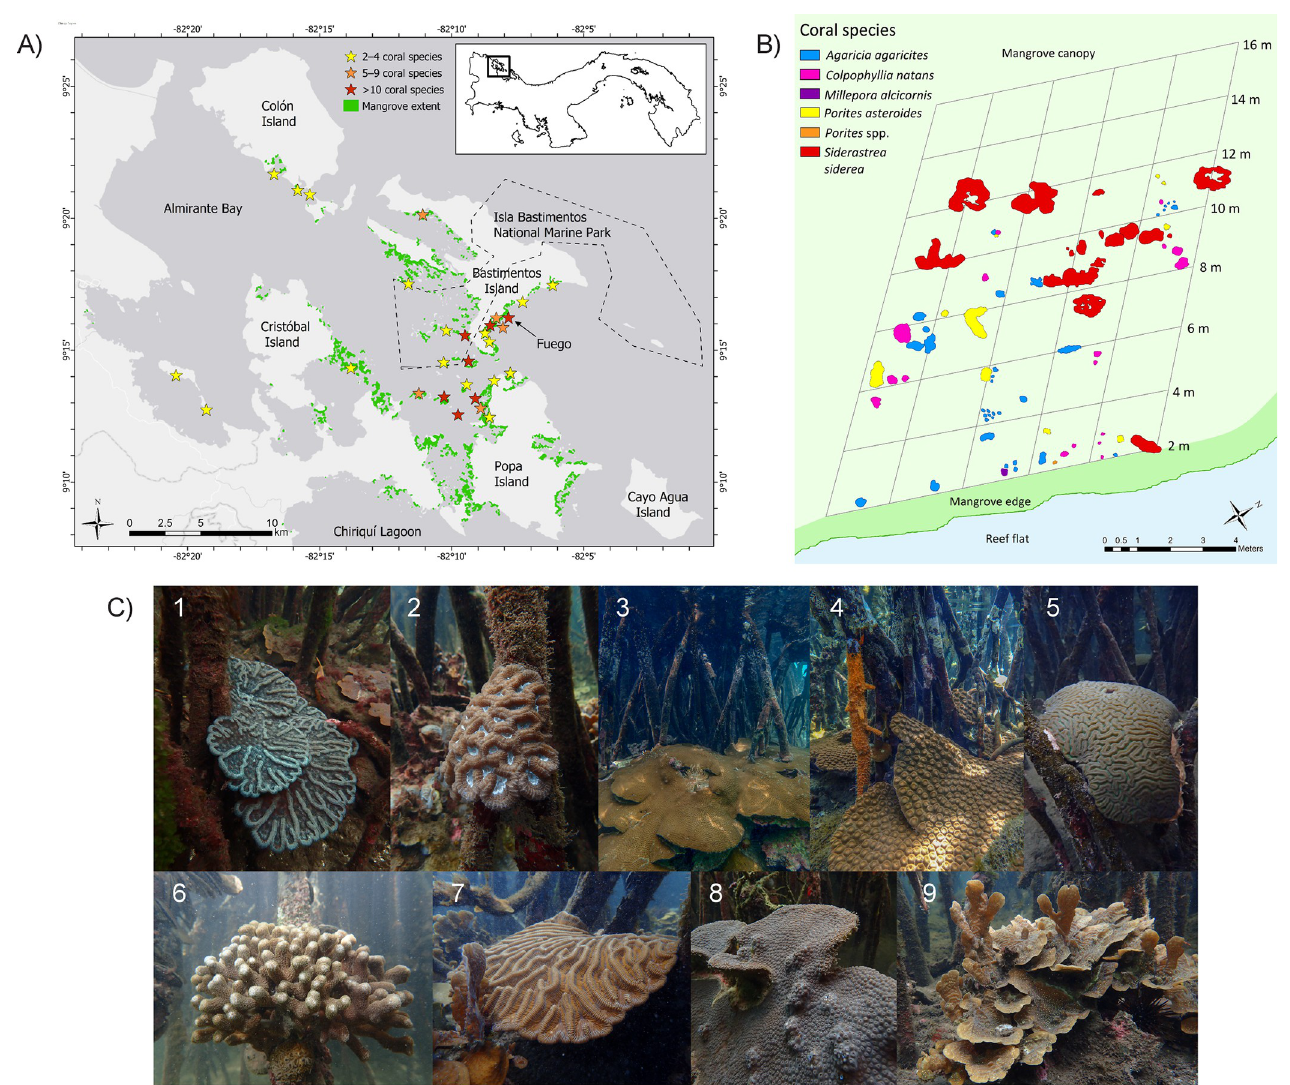
Fig 1. Coexisting mangrove-coral habitats of Bocas del Toro, Panama. (A) Coexisting mangrove-coral sites of Bocas del Toro with coral species richness, mangrove extent, and marine protected area (Isla Bastimentos National Marine Park). (B) mangrove canopy zonation map of coral colonies > 5 × 5 cm at Fuego site. Porites spp. are branching species ( Porites porites , P . furcata , or P . divaricata ). (C) Mangrove coral growth forms and strategies (e.g., growing on or between roots). Coral species: (1) Mycetophyllia aliciae (2) Isophyllia rigida , (3) Siderastrea siderea , (4) Montastraea cavernosa , (5) Diploria labyrinthiformis , (6) P . furcata , (7) Colpophyllia natans , (8) Orbicella faveolata , (9) Agaricia tenuifolia .